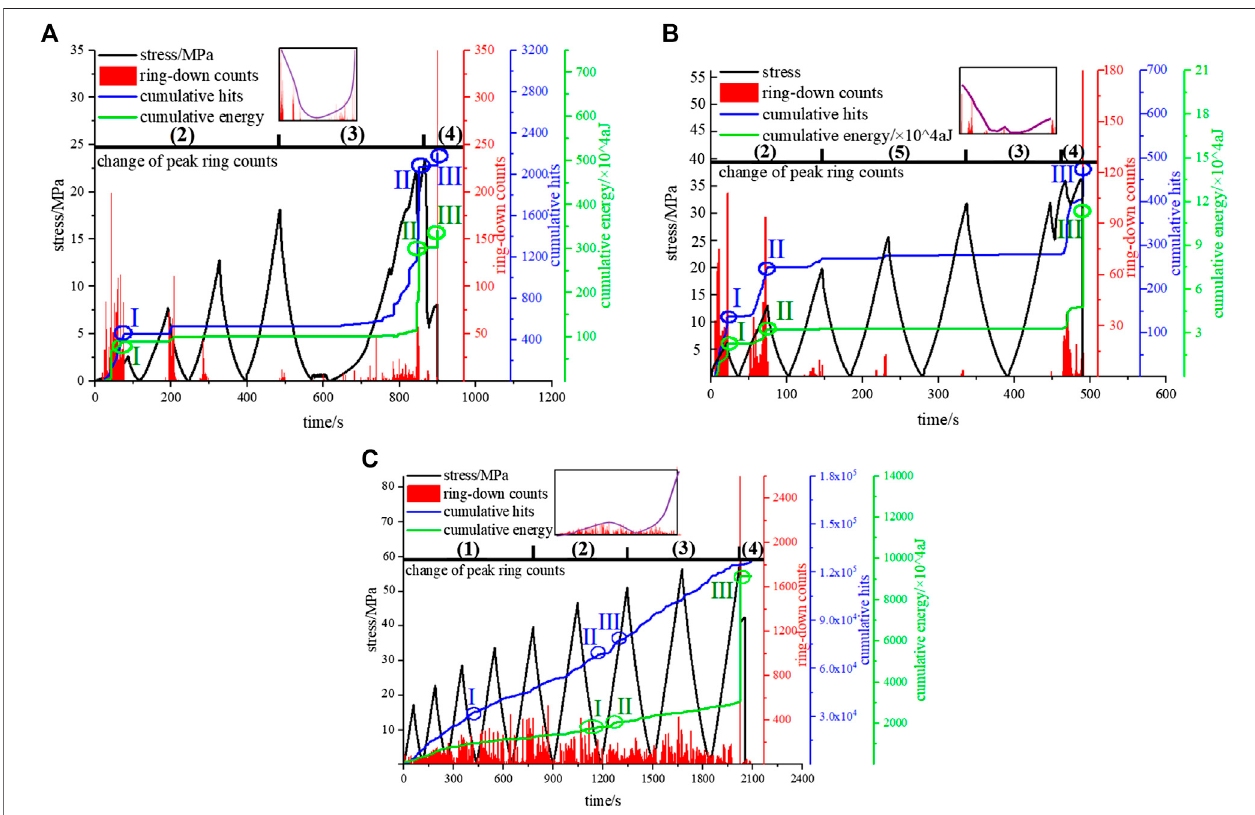
FIGURE 4 | AE test results under different initial stresses. (A) σ 0 (cid:2) 2.5 MPa (B) σ 0 (cid:2) 7.5 MPa; (C) σ 0 (cid:2) 12.5 MPa: 1) slight increase period; 2) attenuation period; 3) intense growth period; 4) postpeak calm period; 5) transition period of increase and then